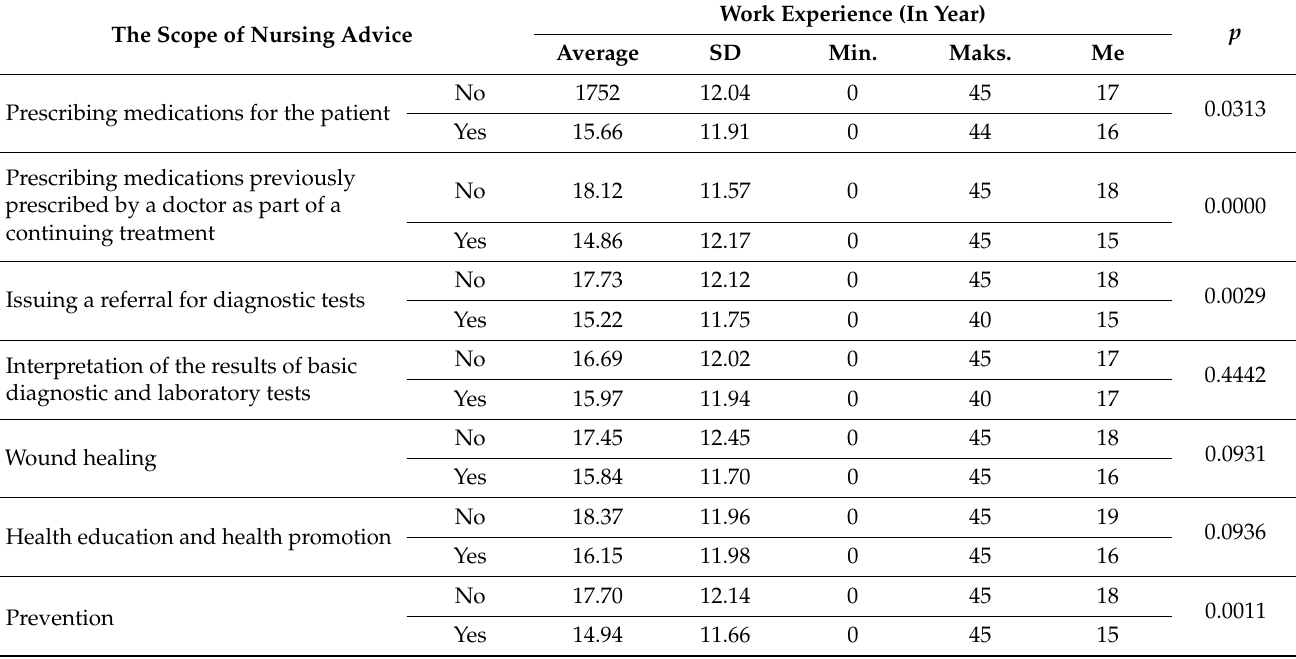
Table 4. The scope of nursing advice depending on the work experience of the surveyed